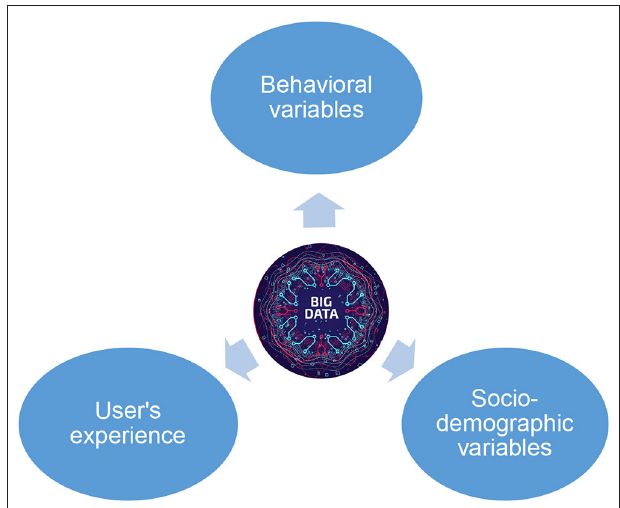
FIGURE 1 | Proposed